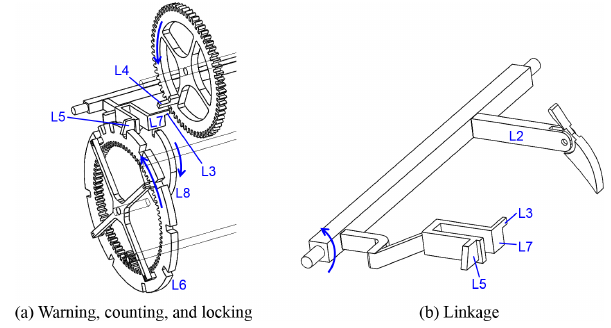
Figure 12. Mechanism and operation of the N3 trigger mechanism. (The trigger is similar to that of N2.)